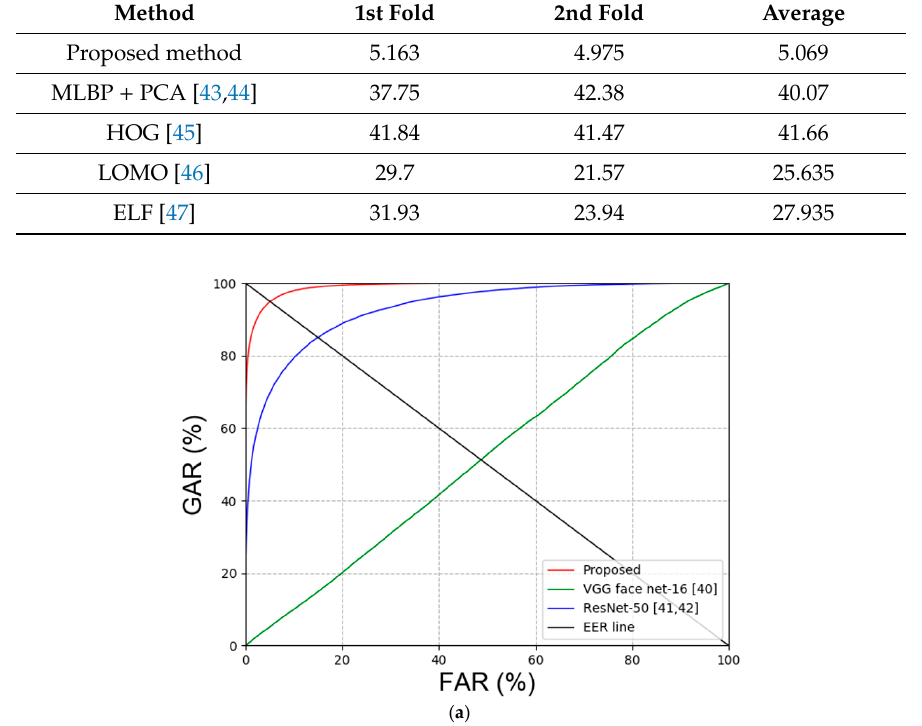
Table 14. Comparison of EER for recognition results via the proposed and previous face and body recognition methods (unit: %).